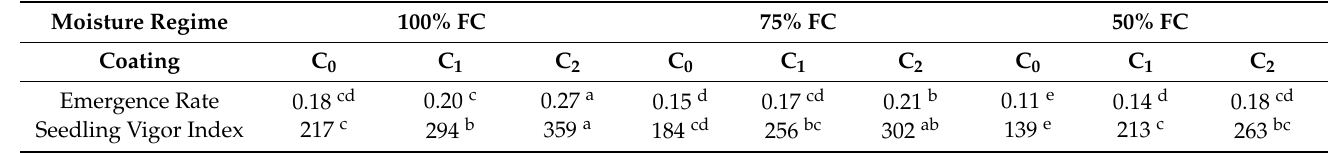
Table 6. Effect of moisture regime and organic coating on emergence rate and seedling vigor index.